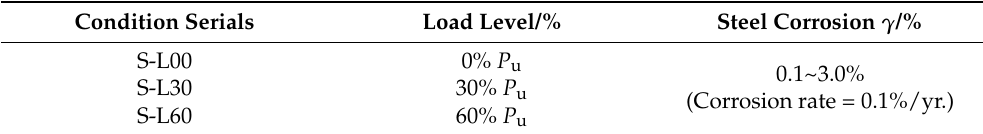
Table 4. Parameters of S-serial simulated beams for investigating the influence of external loads.